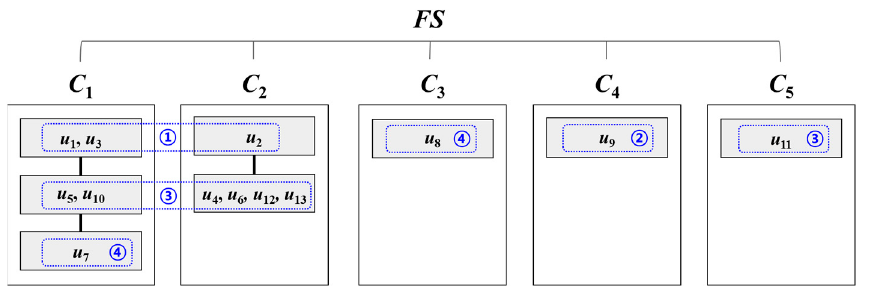
Figure 2. Results after clustering.